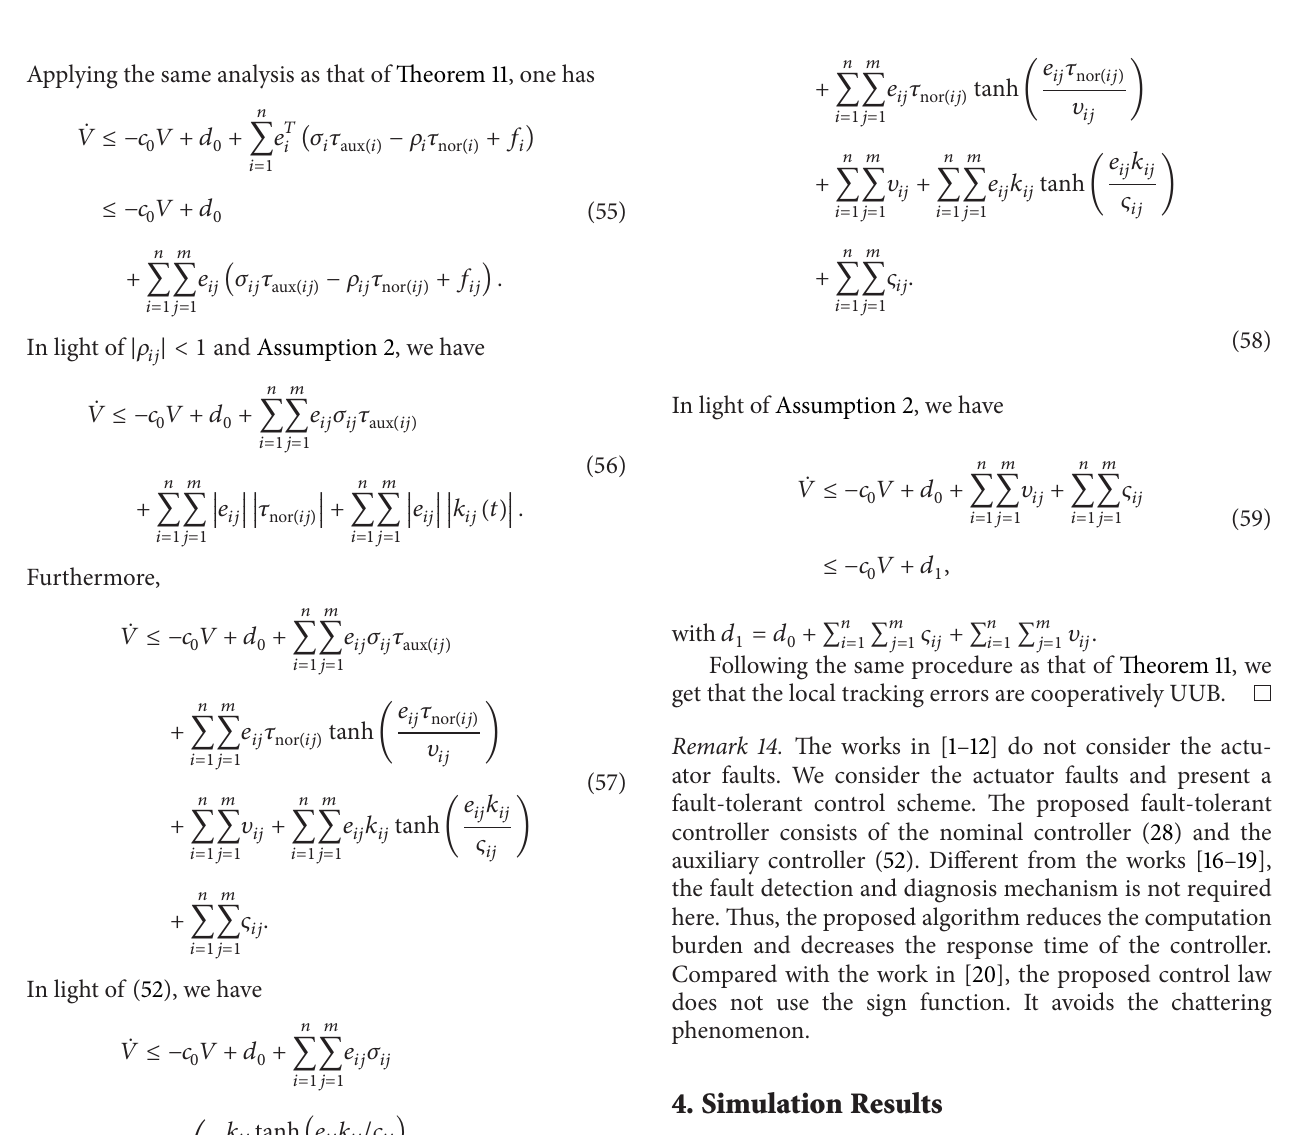
Figure 1: The communication